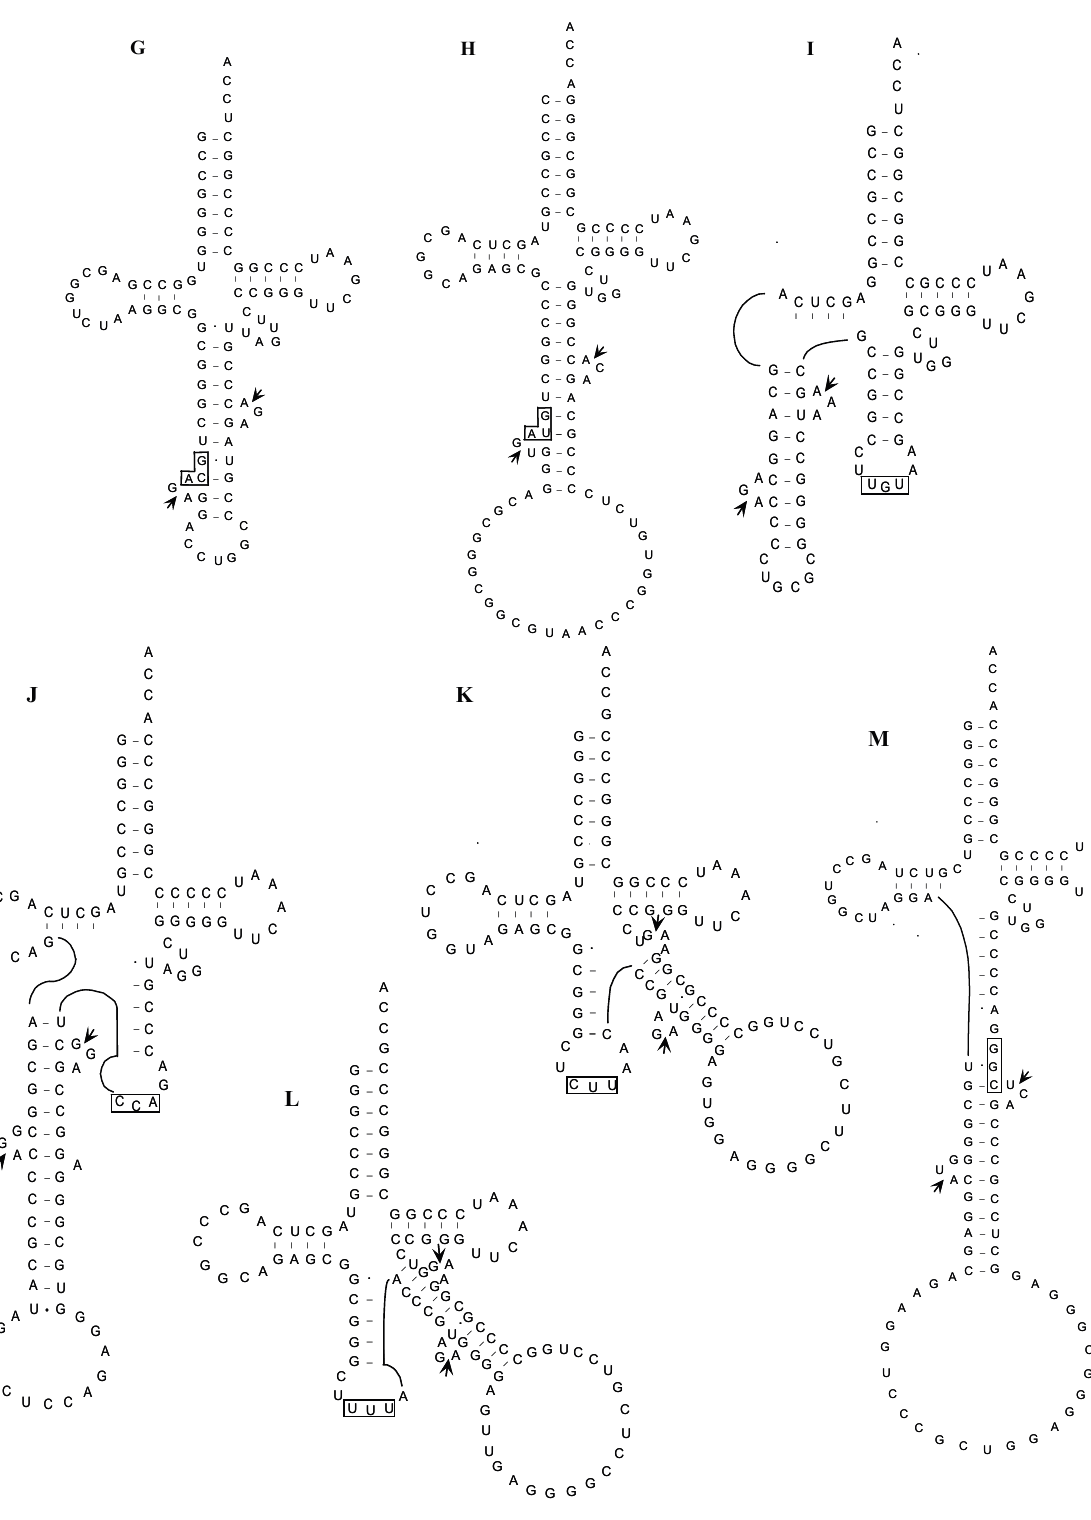
Figure 4. Proposed structures of the unspliced forms of interrupted tRNA molecules in A. pernix K1. Splicing sites and anticodon regions are indicated by short arrows and boxes, respectively. ( A ) tRNA Arg (UCU); ( B ) tRNA Asp (GUC); ( C ) tRNA Met